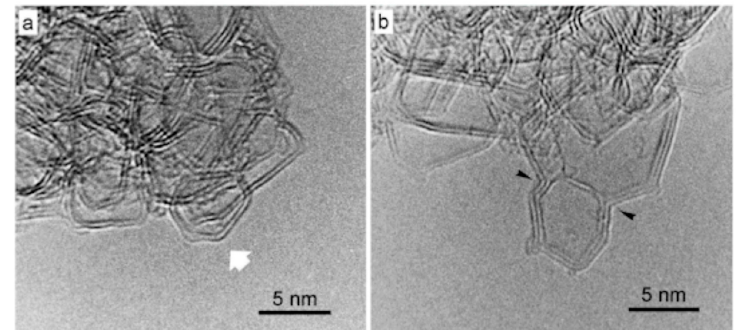
Figure 7. ( a ) Micrograph showing closed structure in polyvinylidene chloride (PVDC)-derived carbon heated at 2600 °C; ( b ) another micrograph of same sample, with arrows showing regions of negative curvature. From work by Harris and Tsang. Reproduced with permission from [61]. Taylor & Francis, 1997.